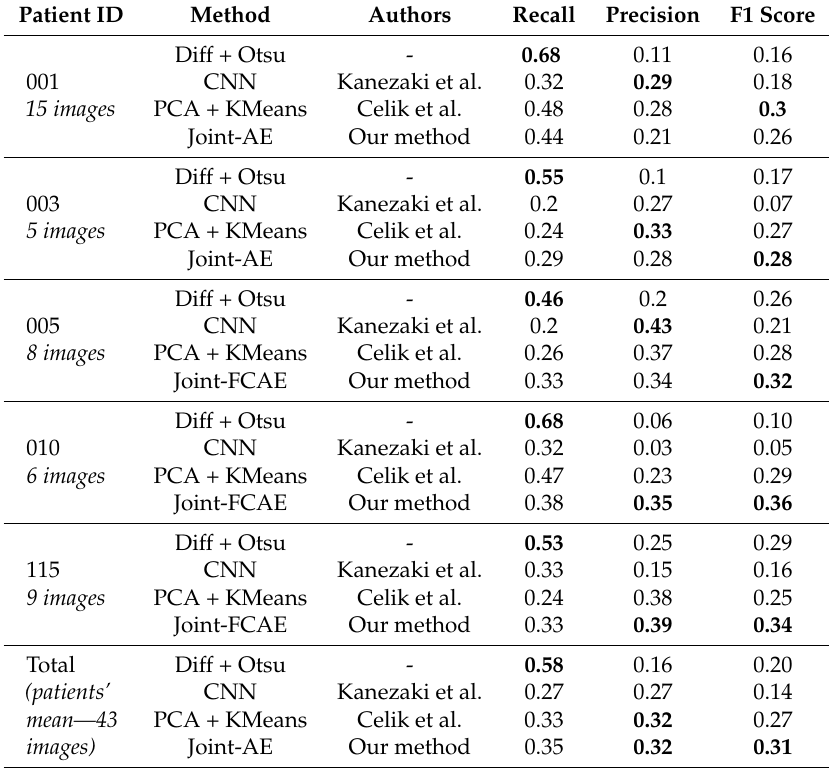
Table 3. Results and comparison of the different approaches. It contains the means of the recall, the precision, and the F1 score for each time series. For each patient, the best dice results are in bold. Patient